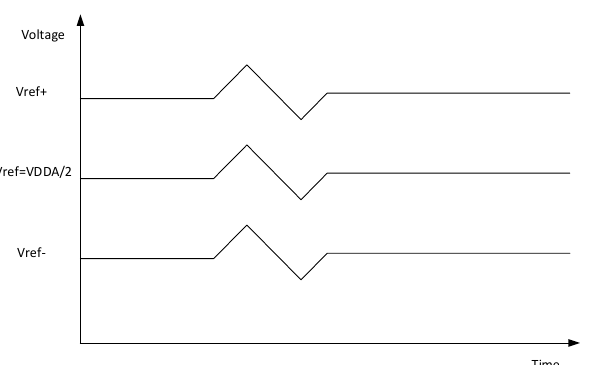
Figure 4. Expected behavior of the group of references with the proper capacitive decoupling effect.